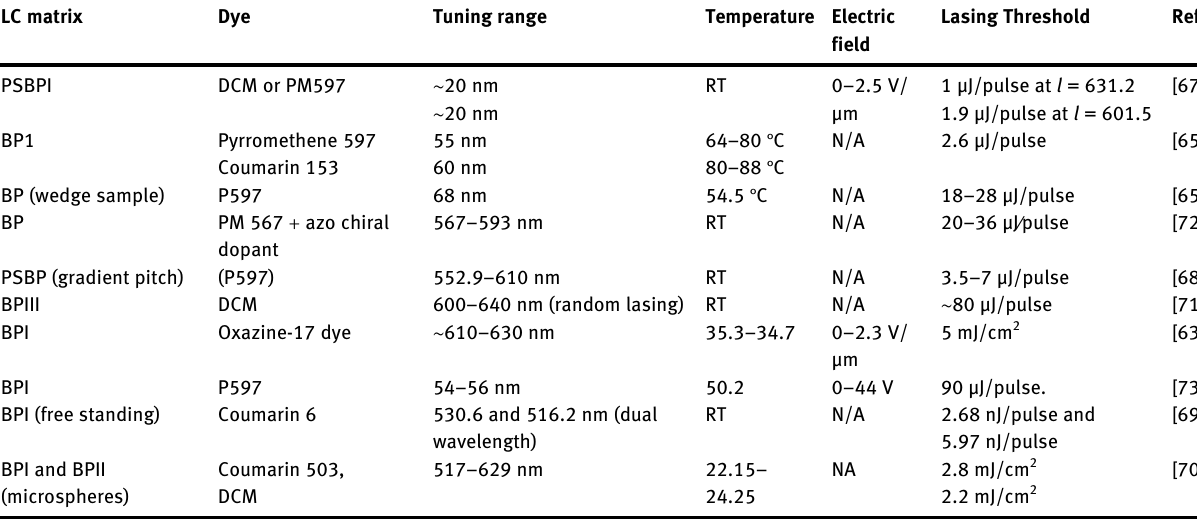
Table  : Blue phase liquid crystalline lasers. LC